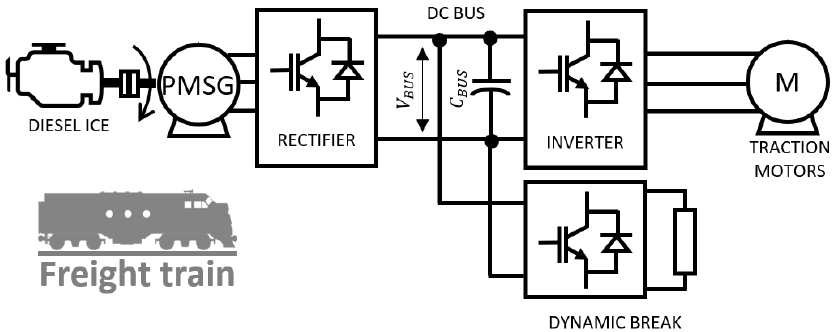
Figure 8. Simplified electrical diagram of the traction drive of diesel-electric vehicles with permanent magnet synchronous generator (PMSG).